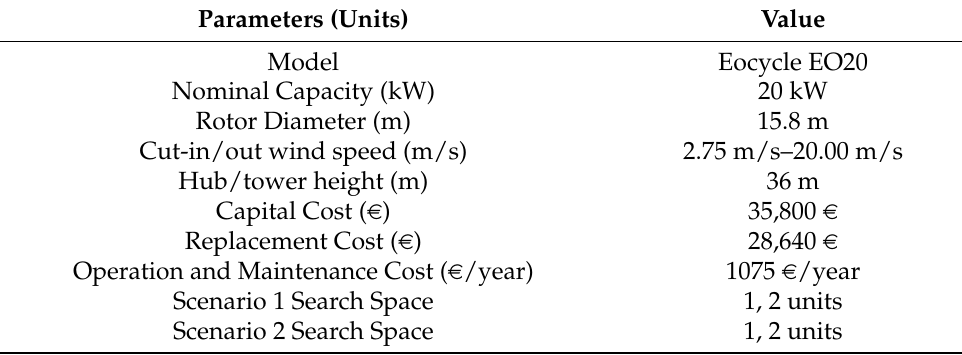
Table 5. Technical specifications and Costs of Eocycle EO20 Wind Turbine.